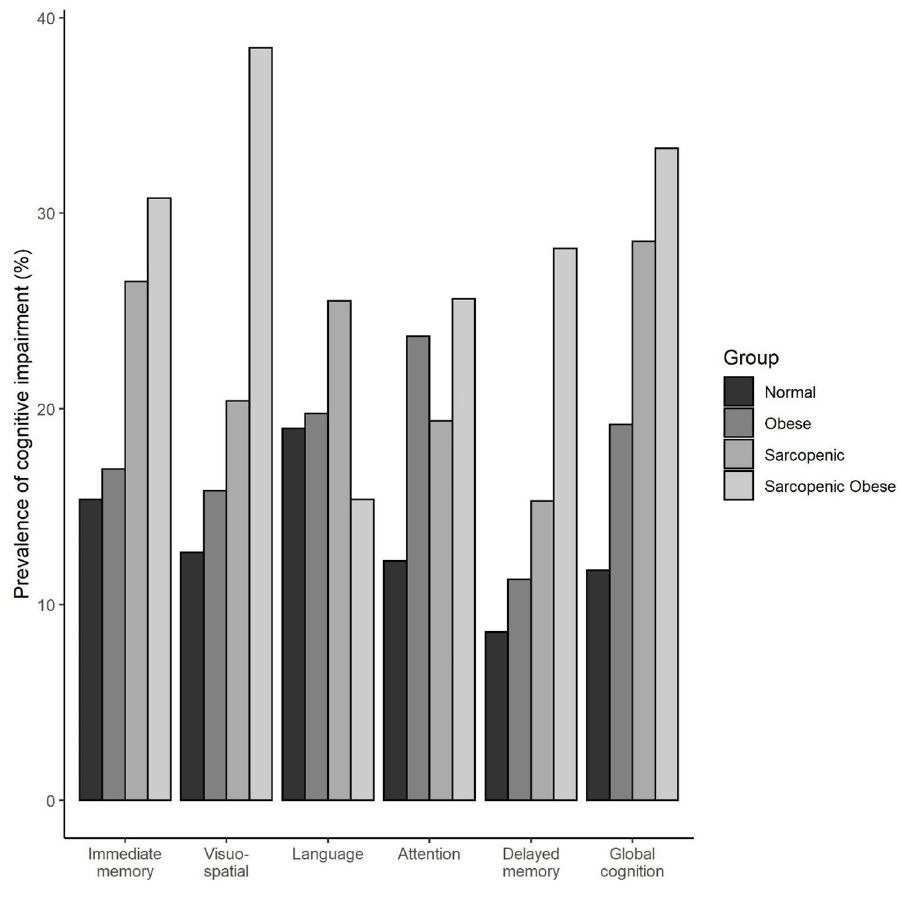
Fig 1. Prevalence of cognitive impairment by sarcopenia and obesity